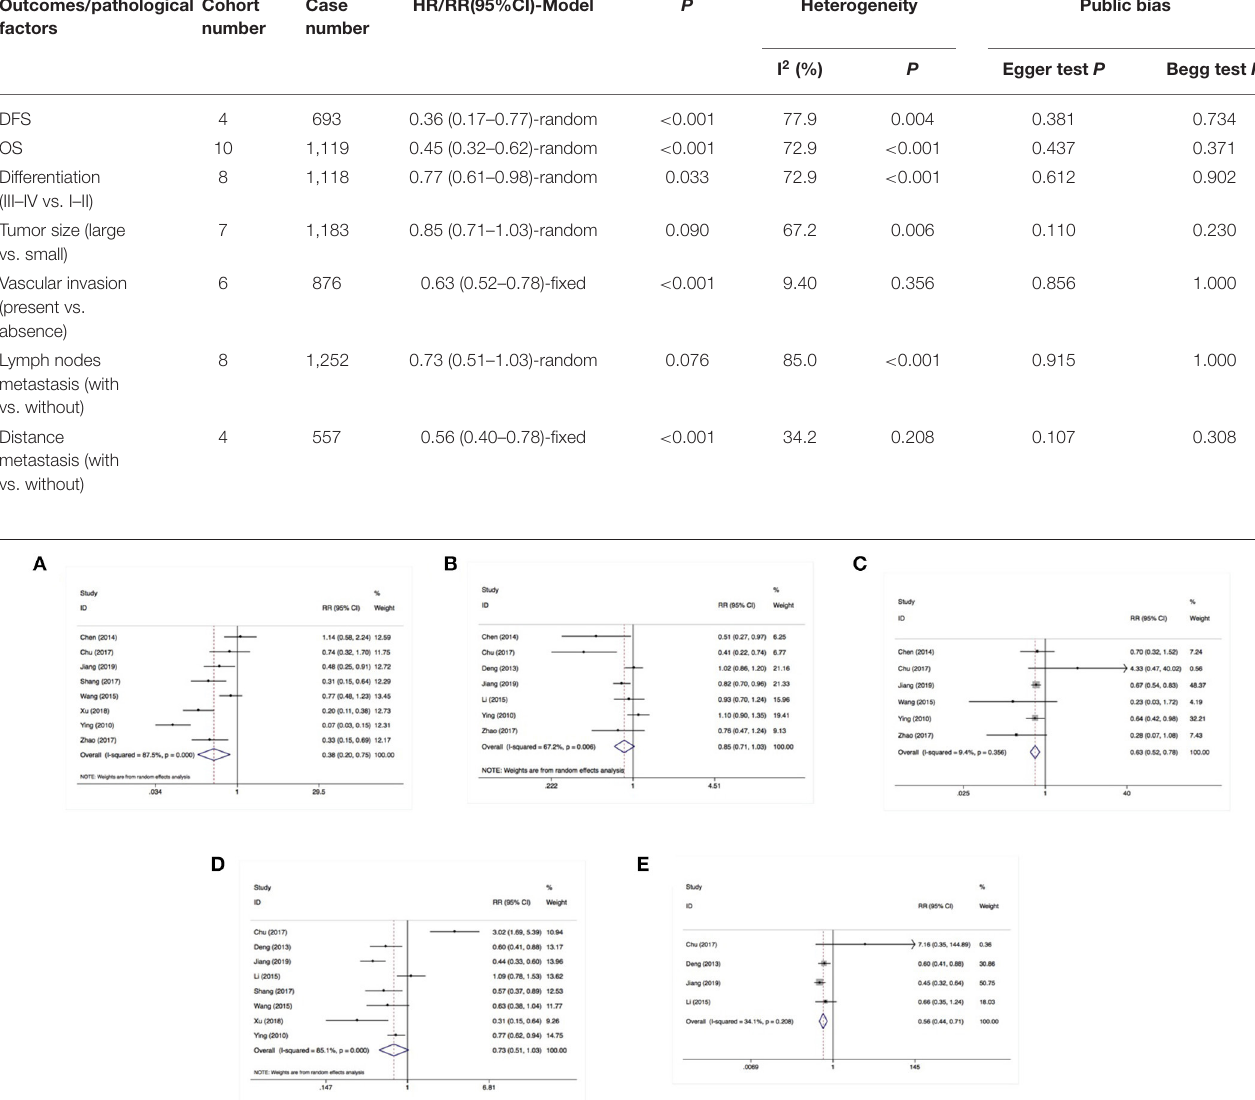
TABLE 2 | Results of meta-analysis of interested outcomes. Outcomes/pathological